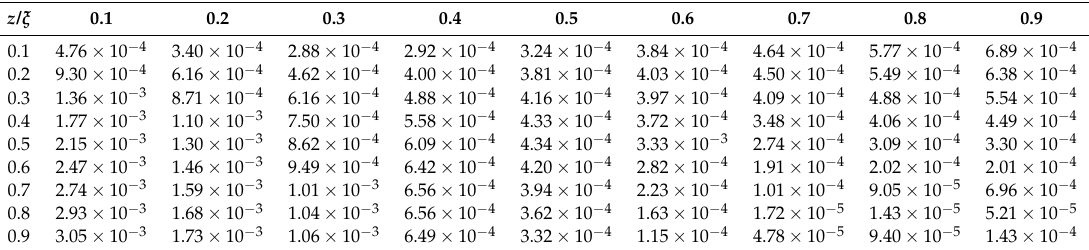
Figure 2. The surfaces show the absolute error of Example 2 with n = 36 ( a = b = 6 ) and for α = 0.7, α = 0.8, α = 0.9 respectively on region Θ . Table 5. Absolute error values of Example 2 for Burgers’ equation with α = 0.9.